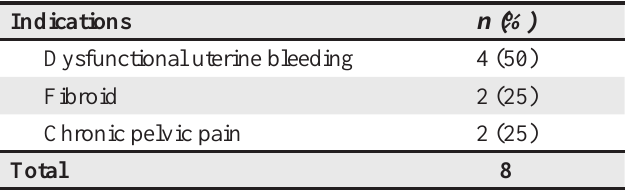
Table 3 : Indications of LAVH